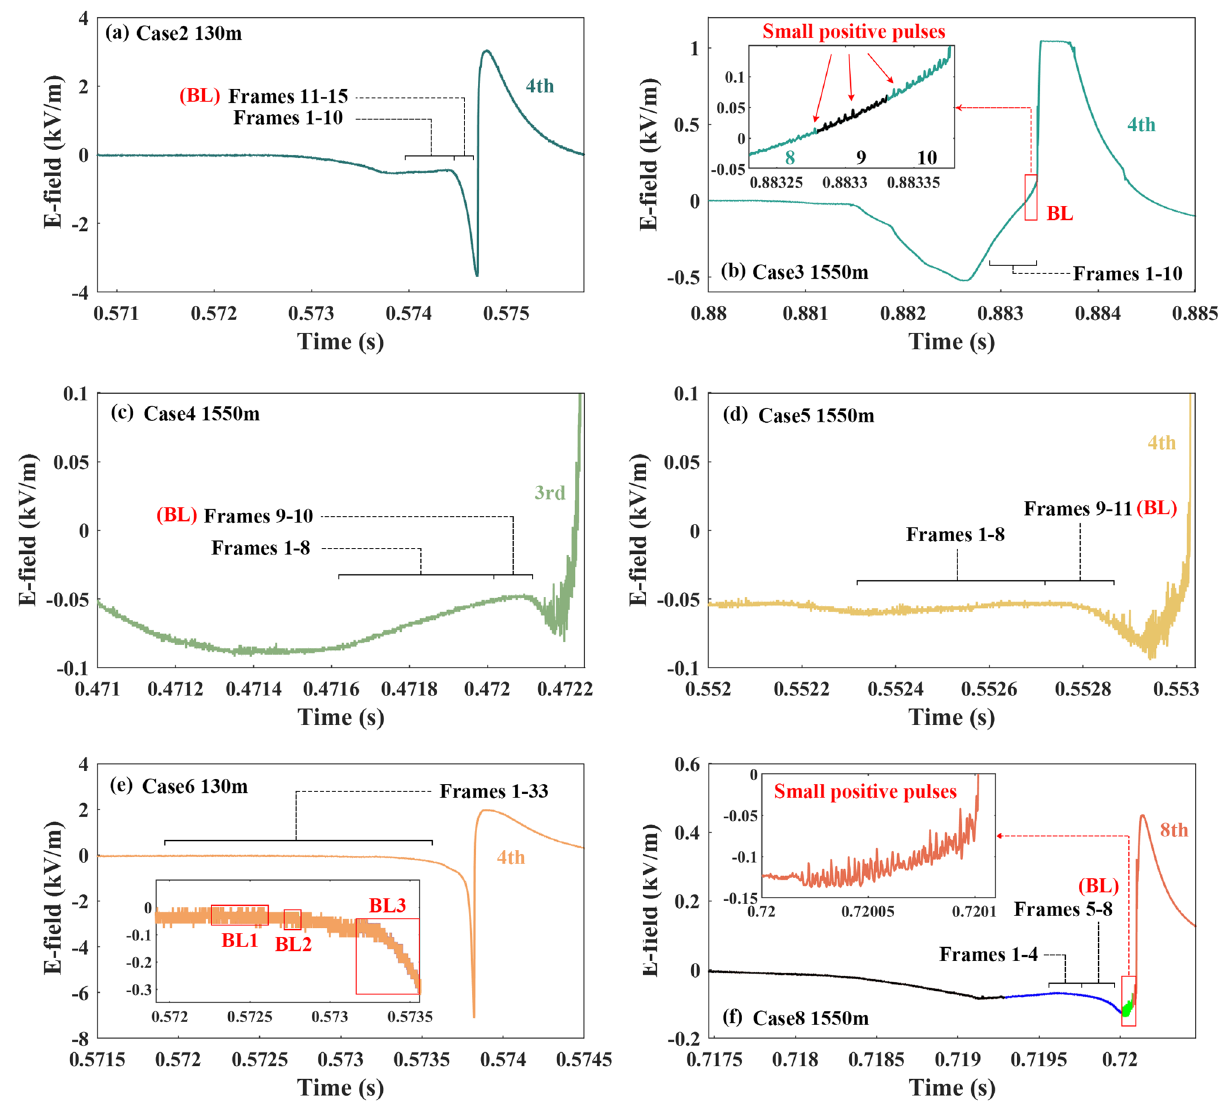
Figure 7. The E-field waveforms of the BL development of Cases 2–6 and belong to this type. Only one BL originated in the two cases reported by Qie et al. 4 , and the intervals were about 160 μs and 300 μs, respectively. The inducement type of BLs develops from decaying unidirectional leaders. In the inducement type, the approach of the faster chasing leader is the key factor causing the unidirectional leader to be bidirectional. In this type, the chasing leader propagates downward along the residual discharge path with a faster speed compared with the chased leader. The gradually approaching chasing leader with negative head causes the decaying chased leader to polarize. The unidirectional chased leader turns to a bidirectional one. Different from the discontinuity type, the reflection type and inducement type of BLs were leaders propagating continuously without the invis- ible duration as recorded by the high-speed camera. At the same time, the occurrence of the reflection type and inducement type of BL is not the result of the initiation of a new leader but the result of the ends of a decaying unidirectional leader beginning to extend forward and backward. The results in Part D present the features and differences of the E-field between the three types. For the reflec- tion type (Cases 2, 4, and 5) and the inducement type, there are fluctuations of the downward leader E-field related to the BL development. The dissipation of the downward leader slows down the negative increase of the E-field. Once the BL development starts, the downward negative end of the BL moves towards the ground with the E-field negatively increasing. It should be pointed out here that if the BL development is closely followed by the RS (Case 3), the change of the E-field may be different. This situation needs further study. For the discontinuity type (Case 6), the close observation result shows no fluctuations in the E-field. The BL development has a much longer duration than the other two BL types.